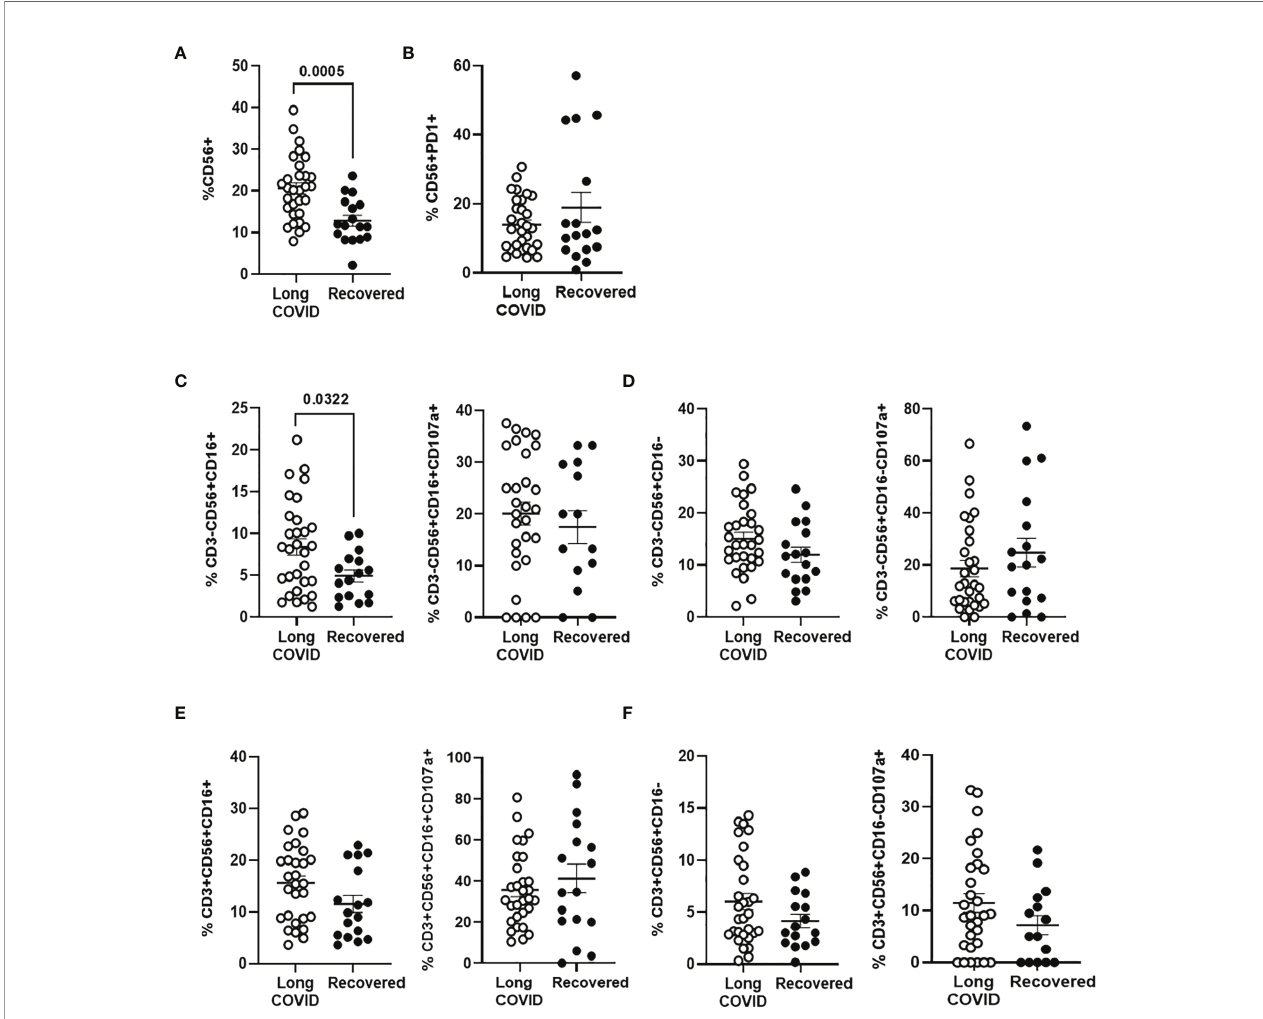
FIGURE 3 | Analysis of NK and NKT cell subpopulations in PBMCs from the Long-COVID and Recovered groups. Total levels of CD56 + NK/NKT cells were analyzed by fl ow cytometry (A) , as well as the expression of the exhaustion marker PD-1 in CD56 + T cells (B) . Total levels of NK cell subpopulation CD56 + CD16 + over CD3 − population or with the degranulation marker CD107a over this population CD3 − CD56 + CD16 + (C) and total levels of NK cell subpopulation CD56 + CD16 − over CD3 − population or with the degranulation marker CD107a over this population CD3 − CD56 + CD16 − (D) were also analyzed by fl ow cytometry. Analysis by fl ow cytometry of the total levels of NKT cell subpopulation CD56 + CD16 + over CD3 + population or with the degranulation marker CD107a over this population CD3 + CD56 + CD16 + (E) and total levels of NKT cell subpopulation CD56 + CD16 − over CD3 + population or with the degranulation marker CD107a over this population CD3 + CD56 + CD16 − (F) . Each dot in the graphs corresponds to one sample, and lines represent mean ± SEM. Statistical signi fi cance was calculated using non- parametric Mann – Whitney test. PBMCs, peripheral blood mononuclear